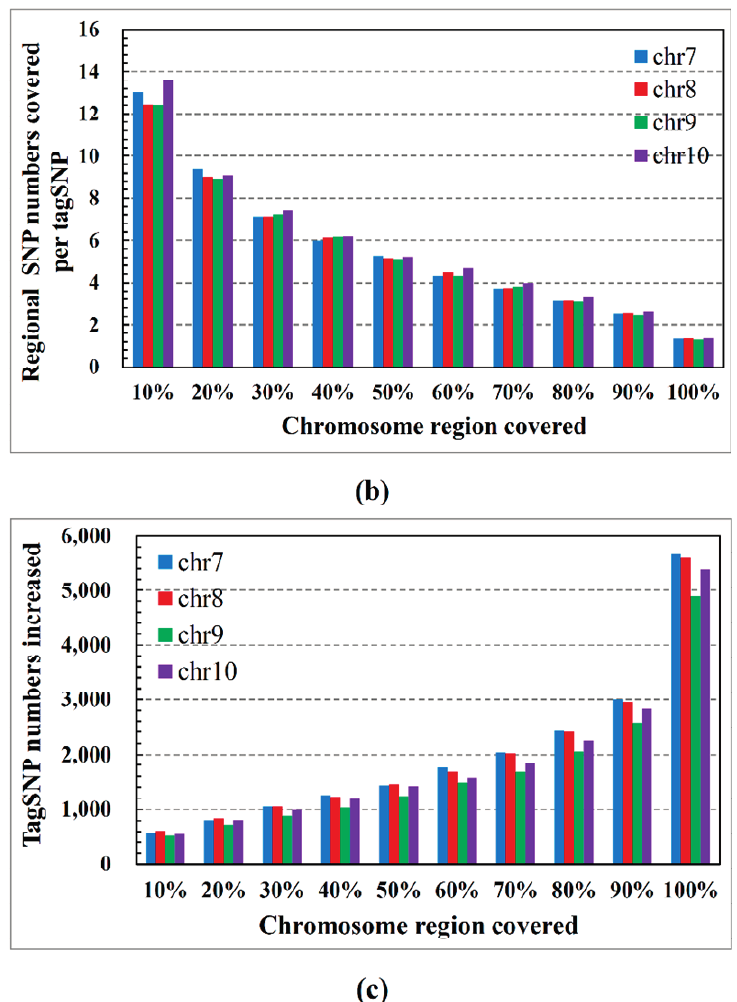
Figure 3. ( a ) Average number of SNPs covered by each tagSNP; ( b ) SNP numbers covered per tagSNP, for each 10% coverage of the chromosomal region and ( c ) Increase